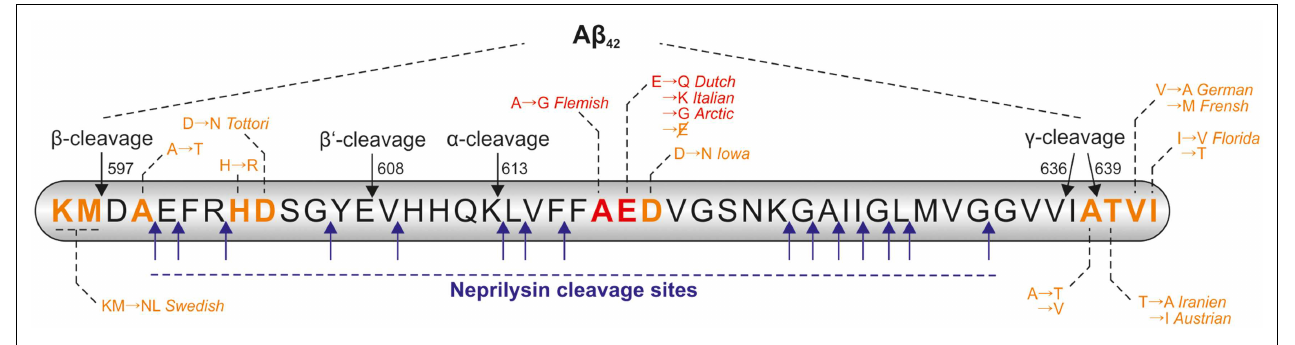
within the A β sequence are reported to result in a higher resistance of the peptide to NEP-catalyzed proteolysis (highlighted in red), other known mutation sites are shown in orange.The amino acid numbers are referring to the APP695